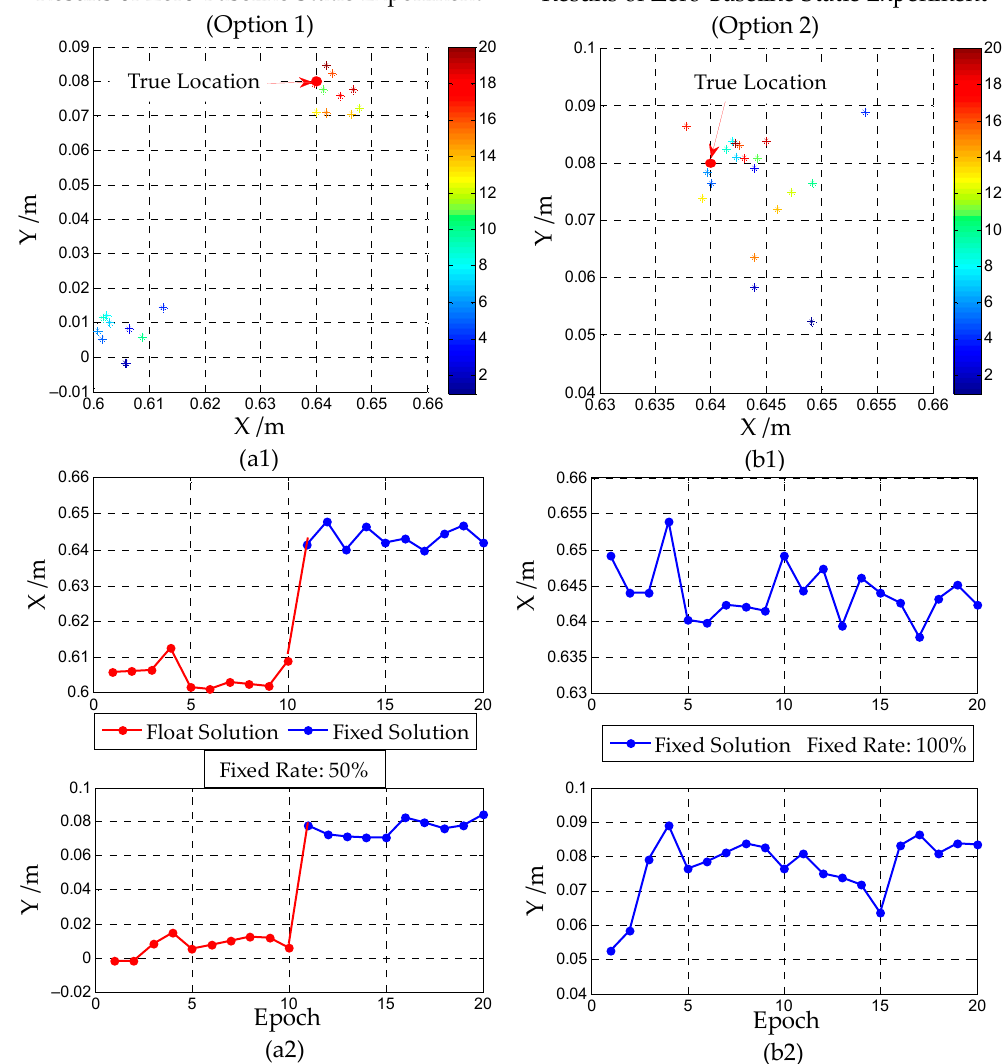
Figure 9. ( a1 , a2 ) Results of Experiment 1 when Using Strategy 1, ( b1 , b2 ) Results of Experiment 1 when Using Strategy 2.